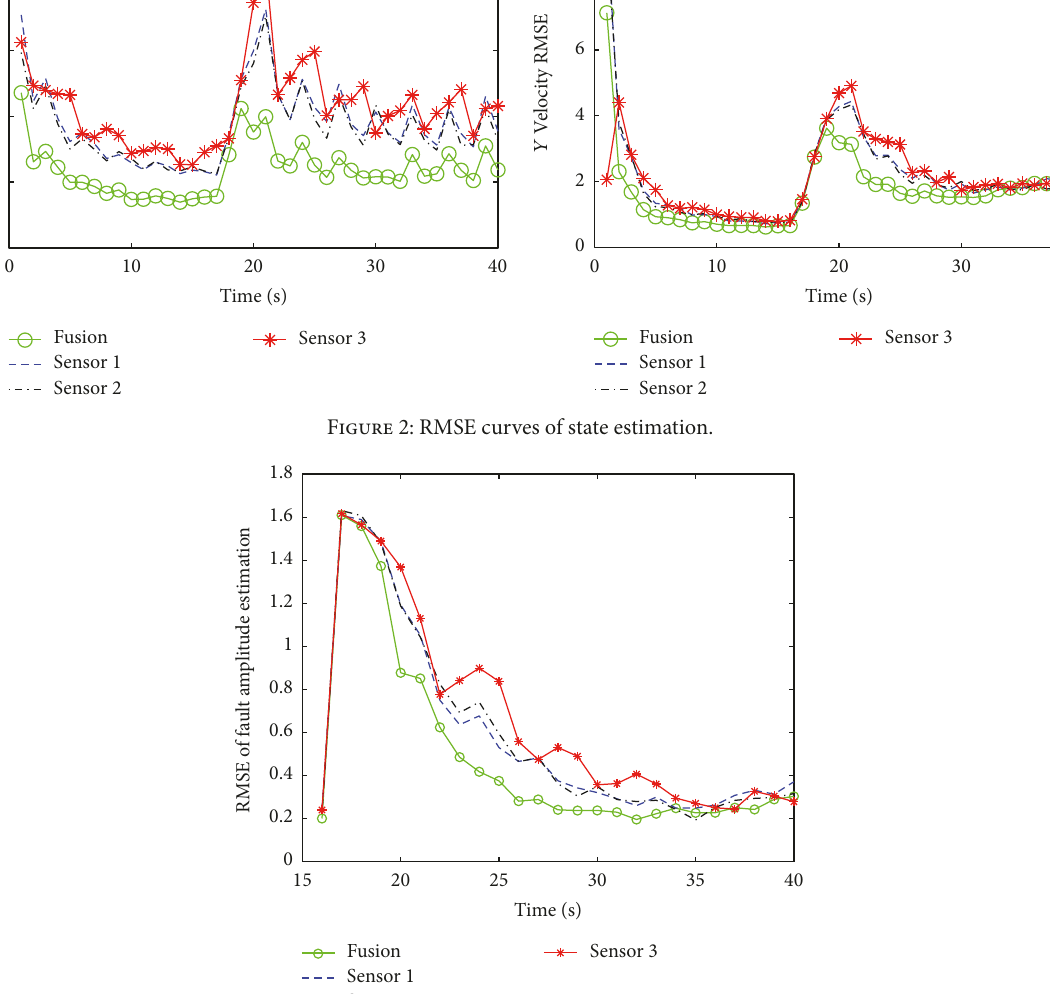
Figure 3: RMSE curves of fault